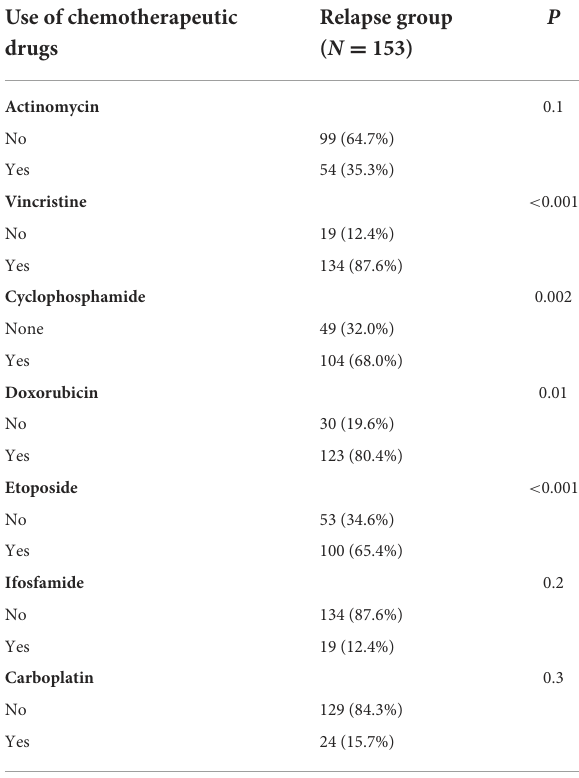
TABLE 6 Log-rank test of chemotherapeutic drugs in the relapse group. Use of